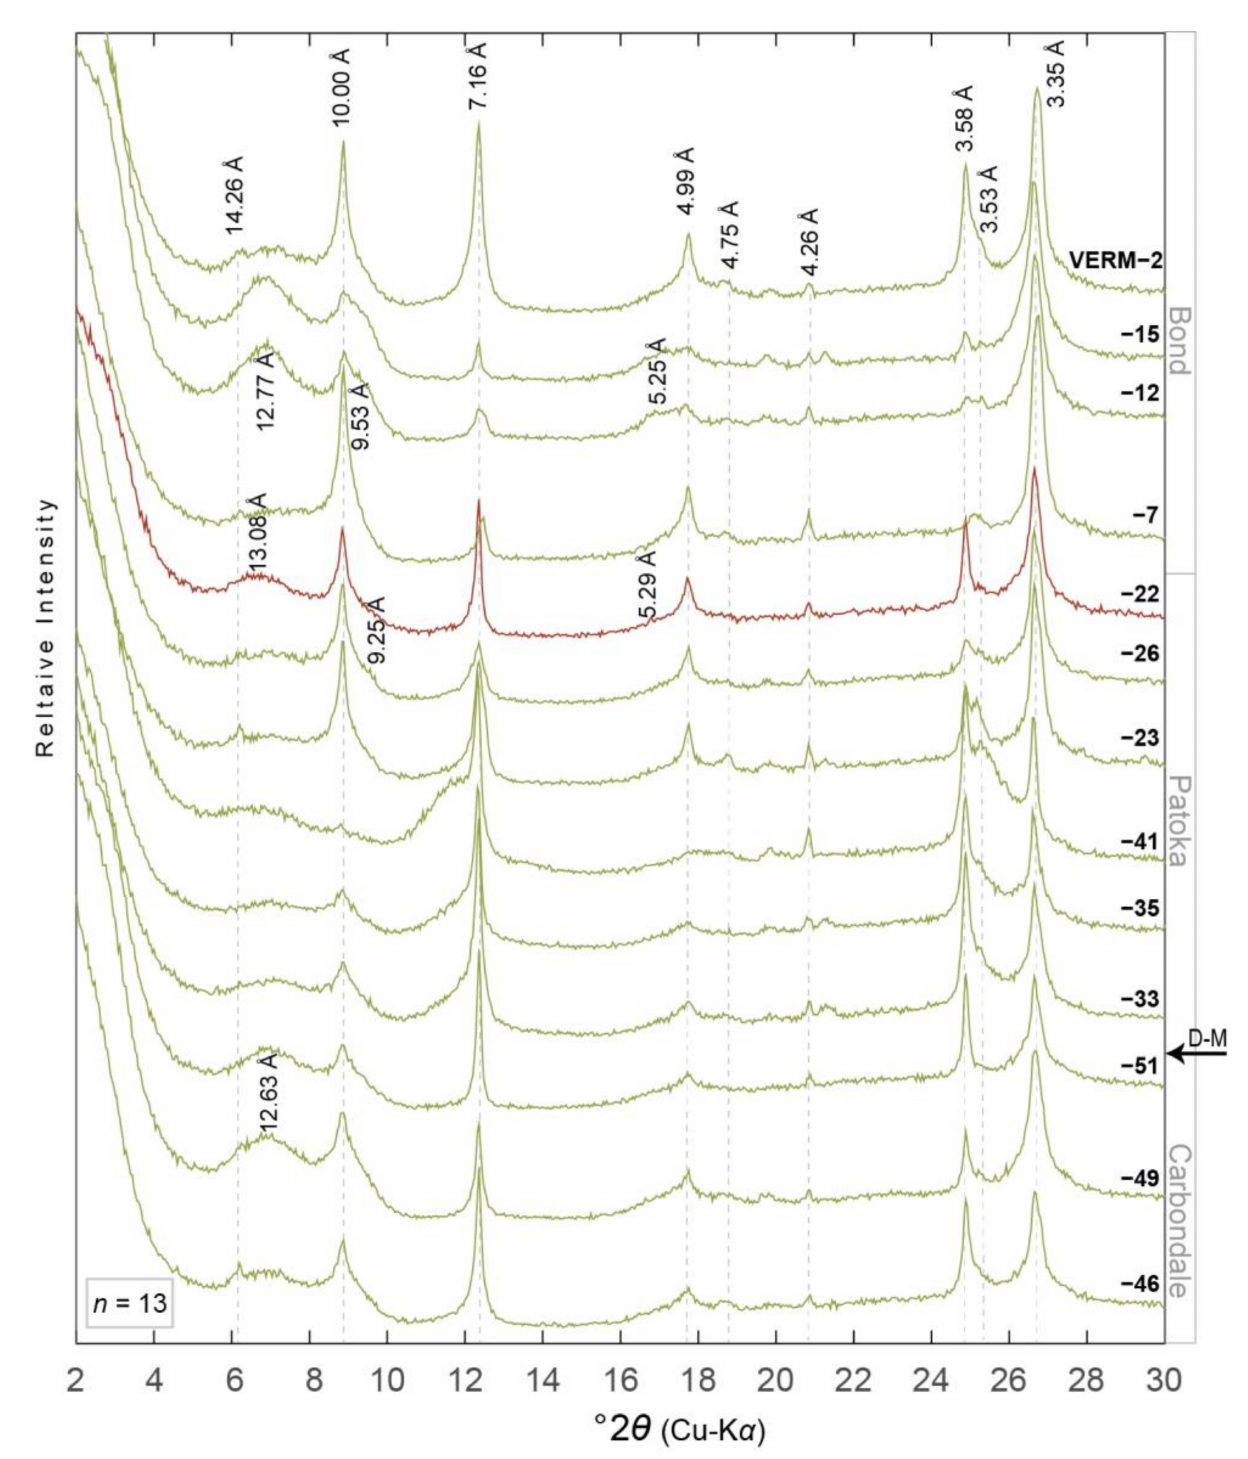
Figure 4. XRD patterns of ethylene glycol saturated oriented aggregates of the <2.0 µ m equivalent spherical diameter clay- sized fraction from paleosols in the Materials Service Corps #F-72-8 (VERM) core ( n = 13). Diffraction patterns are organized with respect to their relative stratigraphic position, i.e., VERM-46 and VERM-2 are stratigraphically the lowest and highest samples, respectively. D-spacing information for minerals discussed herein are noted vertically and in angstroms (Å). Diffraction patterns are colored to correspond with paleosol type, i.e., light green = gleyed calcic Vertisol (Pedotype D [43,44]) and red = calcic Vertisol (Pedotype G). D-M = Desmoinesian–Missourian boundary. Core location noted in Figure 2. See Tables 1 and 2 for more